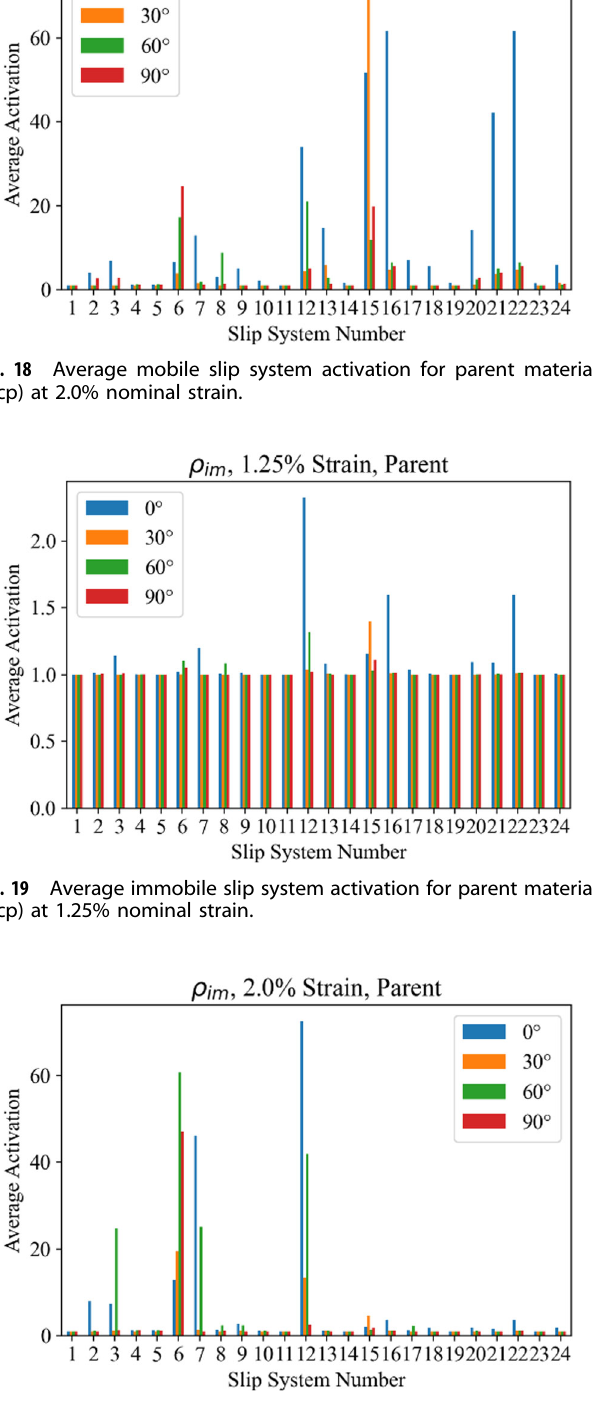
Fig. 20 Average immobile slip system activation for parent material (hcp) at 2.0% nominal strain.